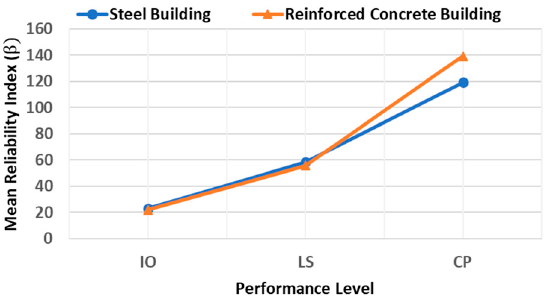
Figure 14. Mean reliability index for steel and reinforced concrete buildings located at Villahermosa, Tabasco (seismic zone B).